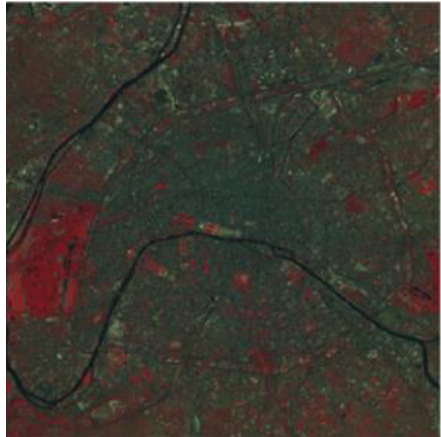
Figure 7. First view of the analyzed land.